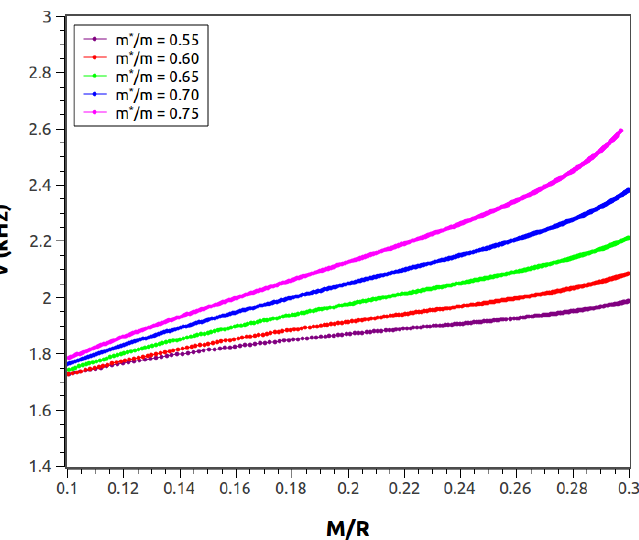
Figure 7. The f -mode frequencies, ν , as a function of stellar compactness, C = M / R , for varying m ∗ / m .